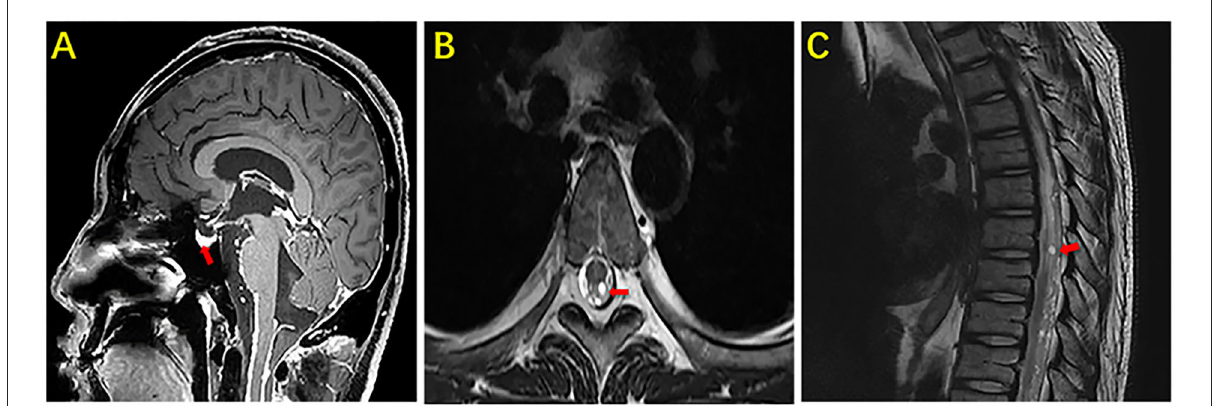
FIGURE2 MRI of the brain and thoracic vertebra of our case. The sagittal section enhanced the image of the brain showing marked nodular enhancement under the pia mater (arrow) (A) . The axial section and sagittal section of the thoracic vertebra showing marked nodular enhancement in the spinal cord (arrow) (B) . The sagittal section of the thoracic vertebra showing marked nodular enhancement in the spinal cord (arrow) (C) .